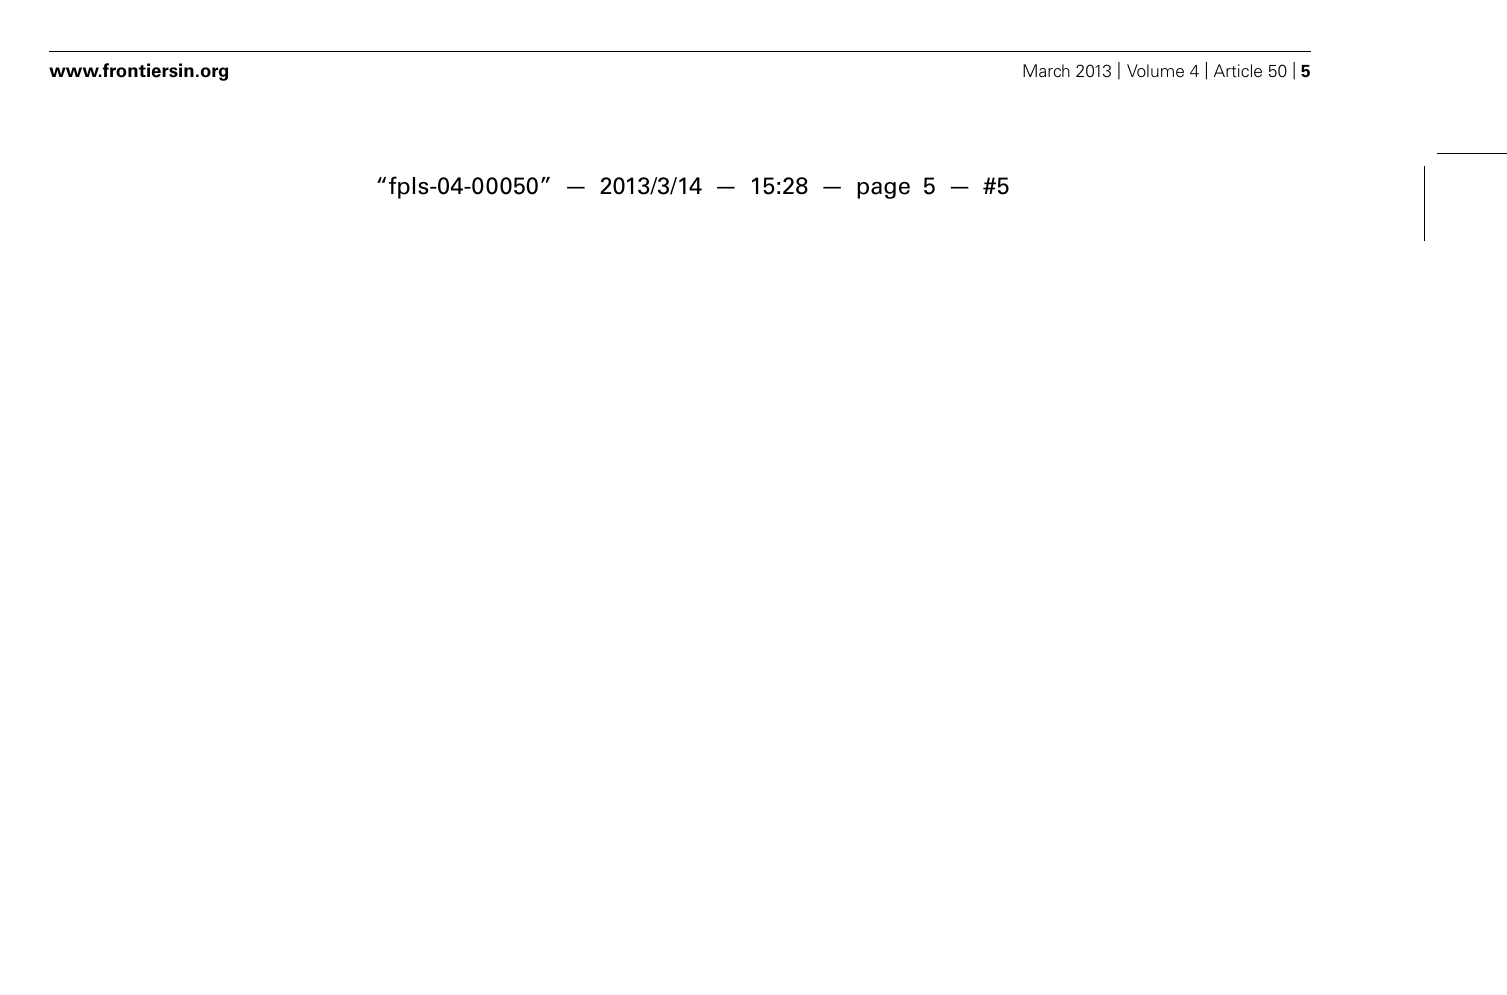
FIGURE 3 |Transcript abundance of candidate BAHD genes in developing Brachypodium tissues estimated by qRT-PCR. Error bars are ± SE from three biological replicates. One-way analysis